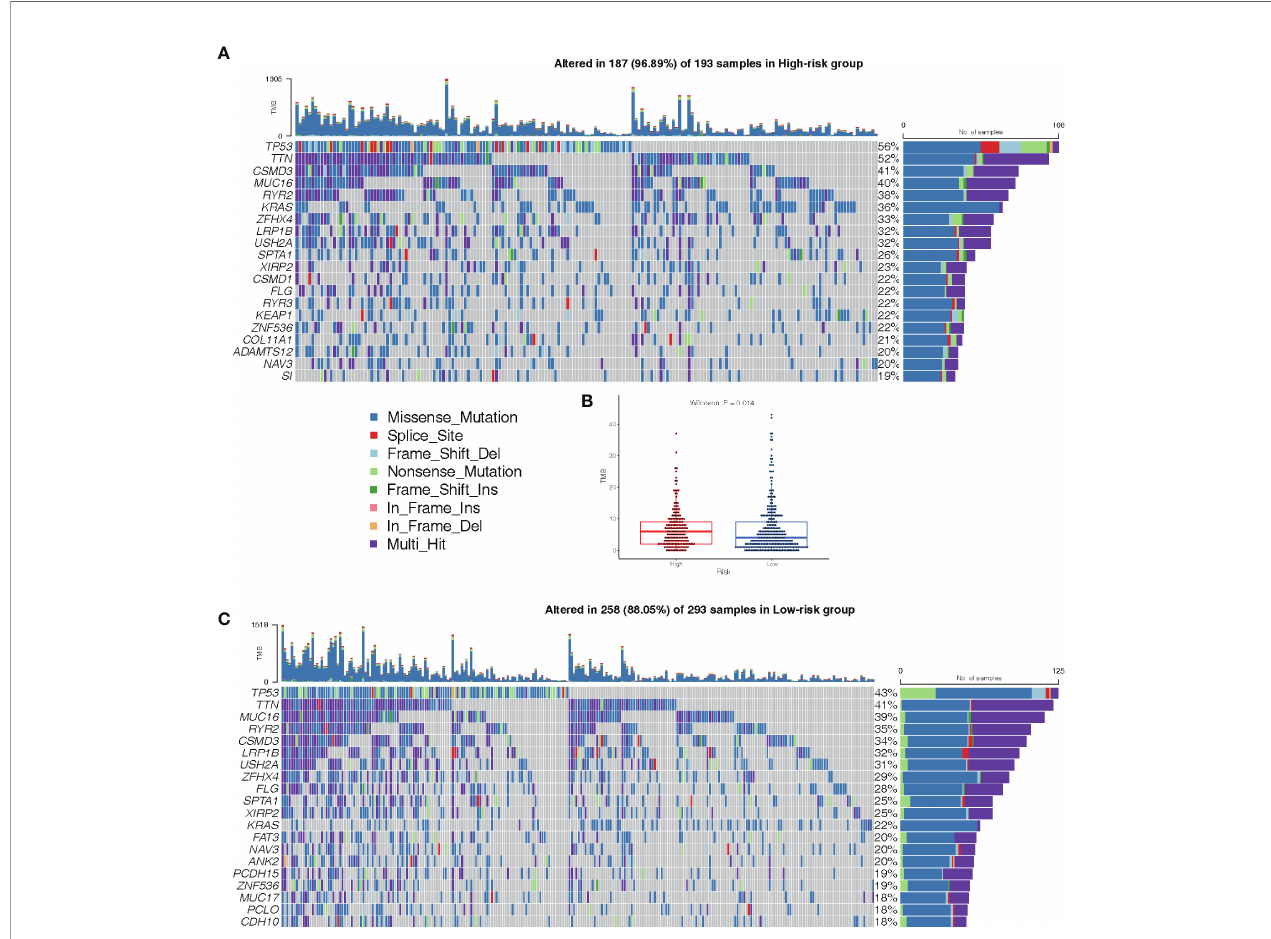
FIGURE 9 | Landscapeof Mutation. (A) The waterfallchart shows the mutation distribution of patients inthe high-risk group. (C) The waterfallchart shows the mutation distribution ofpatients in the low-risk group. The right panel of the waterfall plot shows the mutation frequency, andthe genes are sorted bytheir mutation frequency.The fi gure on the right shows the type of mutation.The histogram above isthe statistical data of TMB of each sample. (B) TMBdifference between high- and low-risk